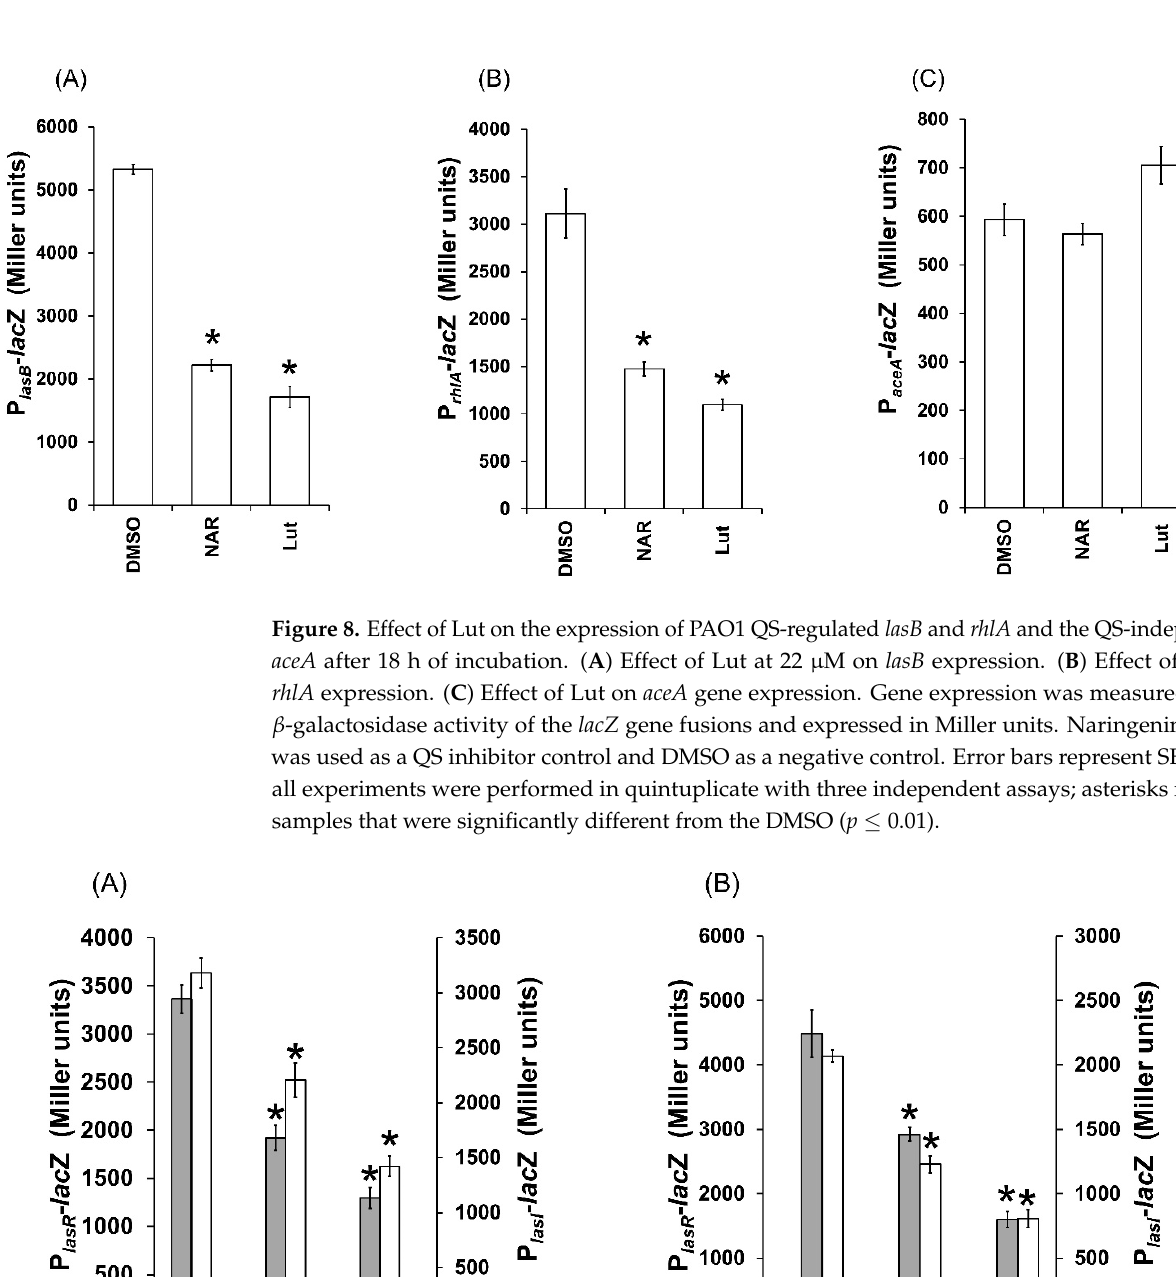
Figure 9. Effect of Lut at 22 µM on the expression of PAO1 QS-regulator genes lasR / I and rhlR / I after 18 h of incubation. ( A ) Effect of Lut on lasR (grey bar) and lasI (clear bar) expression. ( B ) Effect of Lut on rhlR (grey bar) and rhlI (clear bar) expression. Gene expression was measured as the β -galactosidase activity of the lacZ gene fusions and expressed in Miller units. Naringenin (NAR) was used as a QS inhibitor control and DMSO as a negative control. Error bars represent SEM, and all experiments were performed in quintuplicate with three independent assays; asterisks indicate samples that were significantly different from the DMSO ( p ≤